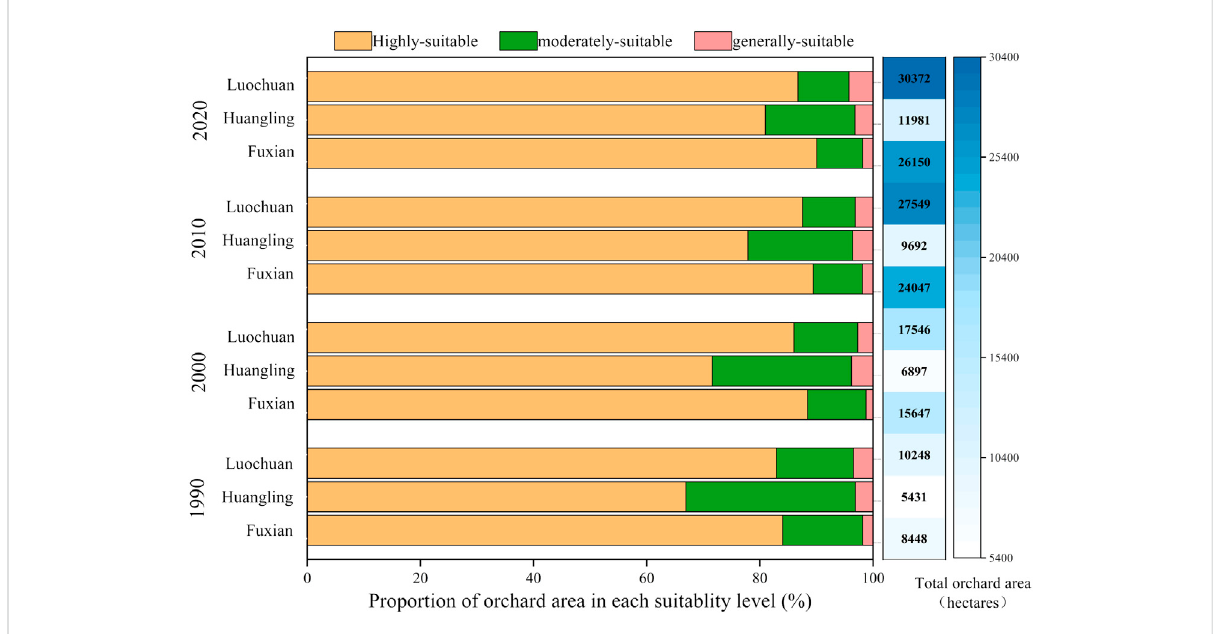
FIGURE 10 Dynamics of orchard area in Fuxian, Huangling and Luochuan under different suitability levels.